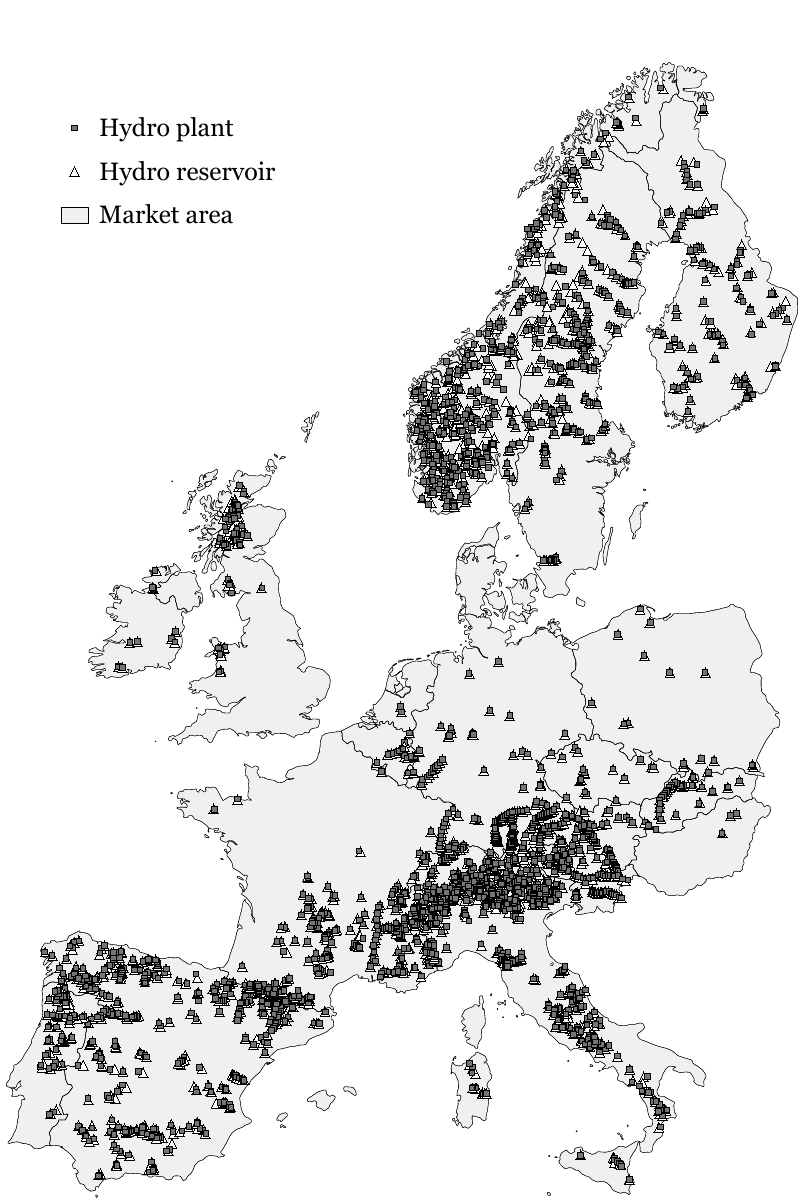
Figure 1. Map of detailed hydro plants (2660 in total) and hydro reservoirs (3307 in total) across the covered market areas in